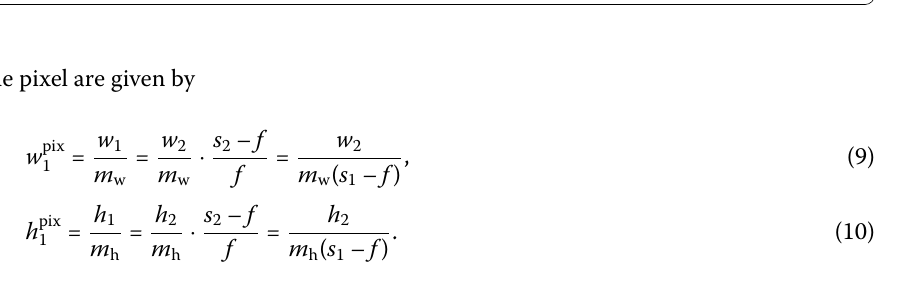
Figure 6 Illustration of the lateral resolution of an optical system with a pixel sensor (CCD/CMOS): Two point sources can be laterally resolved if their images are separated by at least one pixel